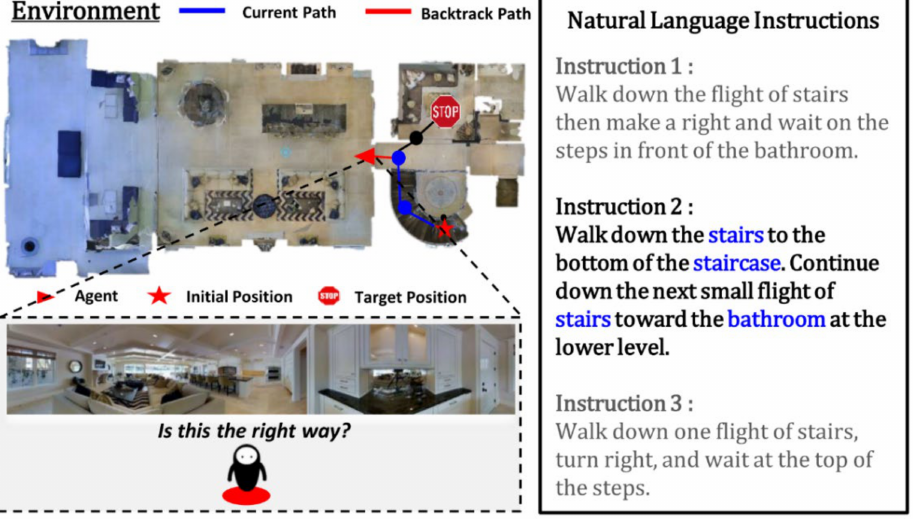
Figure 1. Examples of vision and language navigation (VLN)